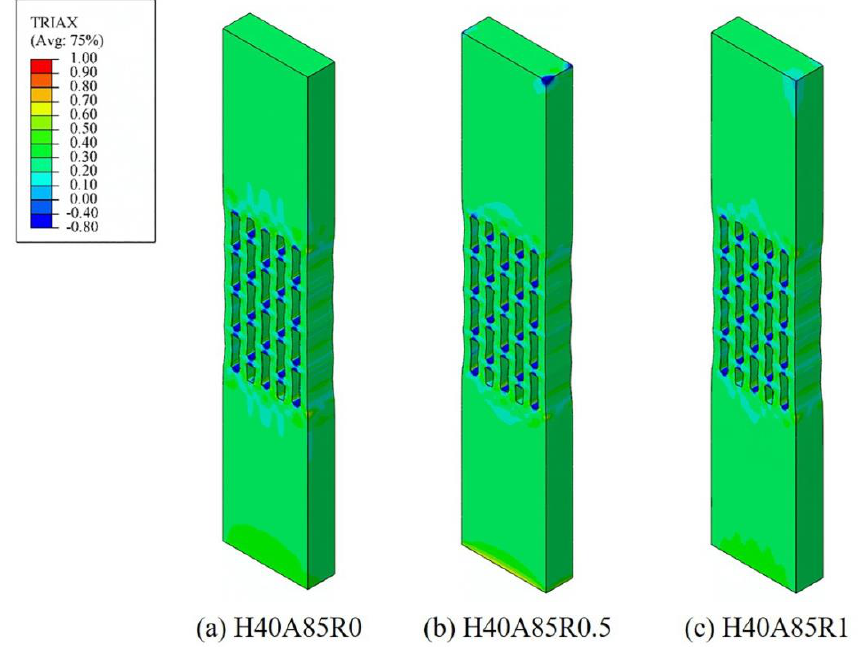
Figure 19. E ff ect of chamfering radius on stress triaxiality with ( a ) H40A85R0, ( b ) H40A85R0.5 and Figure 19. Effect of chamfering radius on stress triaxiality with (a) H40A85R0, (b)H40A85R0.5 and (c) ( c ) H40A85R1.